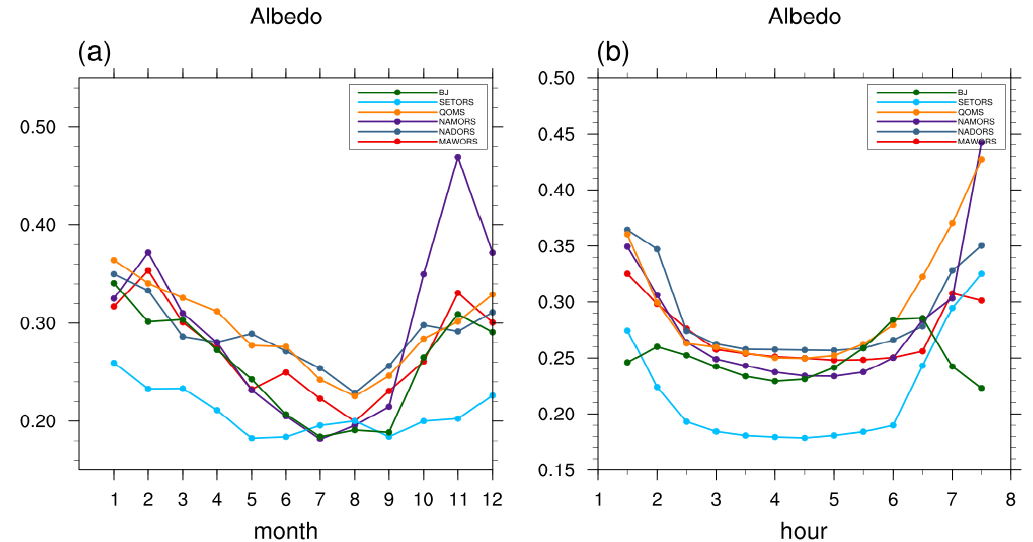
Figure 15. Annual variation of surface albedo ( a ) and diurnal variation of surface albedo ( b ) at each station.